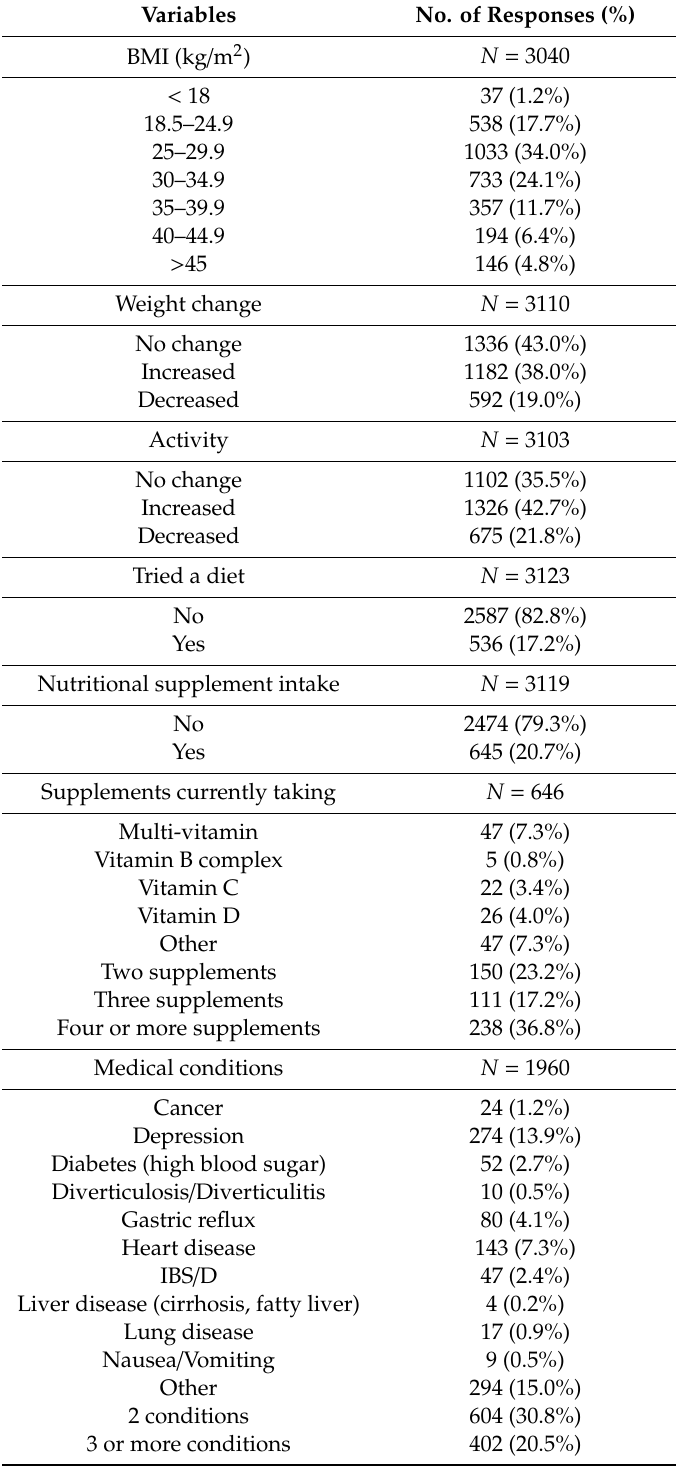
Table 3. Participants’ general health characteristics and